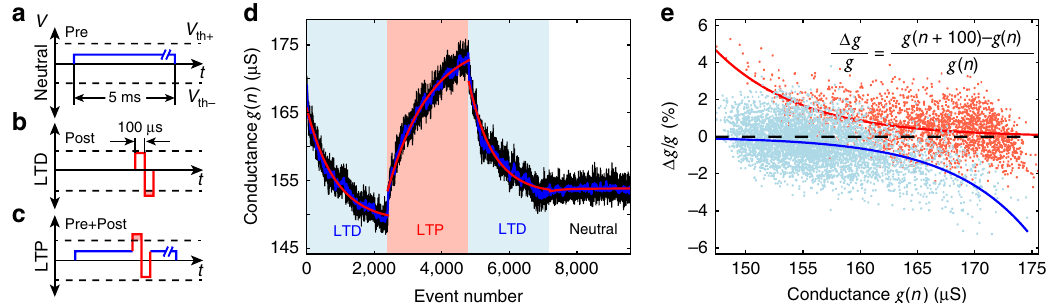
Figure 1 | Weight-dependent STDP in memristors. ( a – c ) Memristor electrical biasing scheme used to test STDP. V th þ , V th (cid:2) : memristor switching thresholds. Data for individual device thresholds in Supplementary Table 2. Voltage levels used to induce LTP and LTD in Supplementary Table 3. Red shading: supra-threshold portions of the input affecting the memristor resistive state. ( d ) Typical experimental results from TiO 2 device. Black trace: raw data; blue trace: 10-point moving average; red trace: exponential fitting. Red shading: LTP. Blue shading: LTD. No shading: neutral region, no plasticity triggered. ( e ) Experimental data and exponential fittings describing STDP magnitude (relative change in device conductance g ) as a function of initial memristor conductance. Red line: LTP fitting. Blue line: LTD fitting. Black dashed line: zero conductance change level. Same data as in d